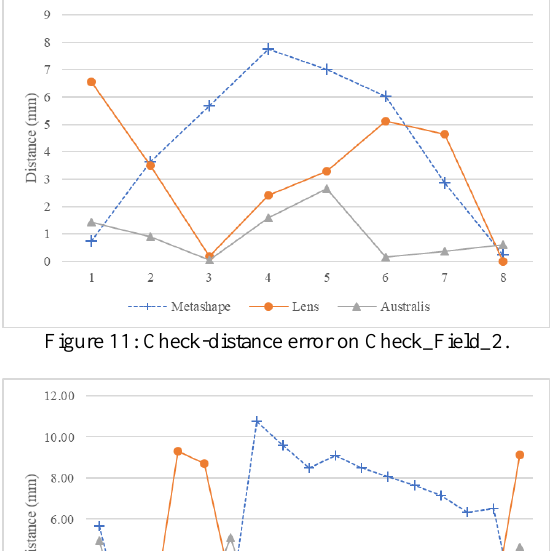
Figure 10: Check-distance error on Check_Field_1.